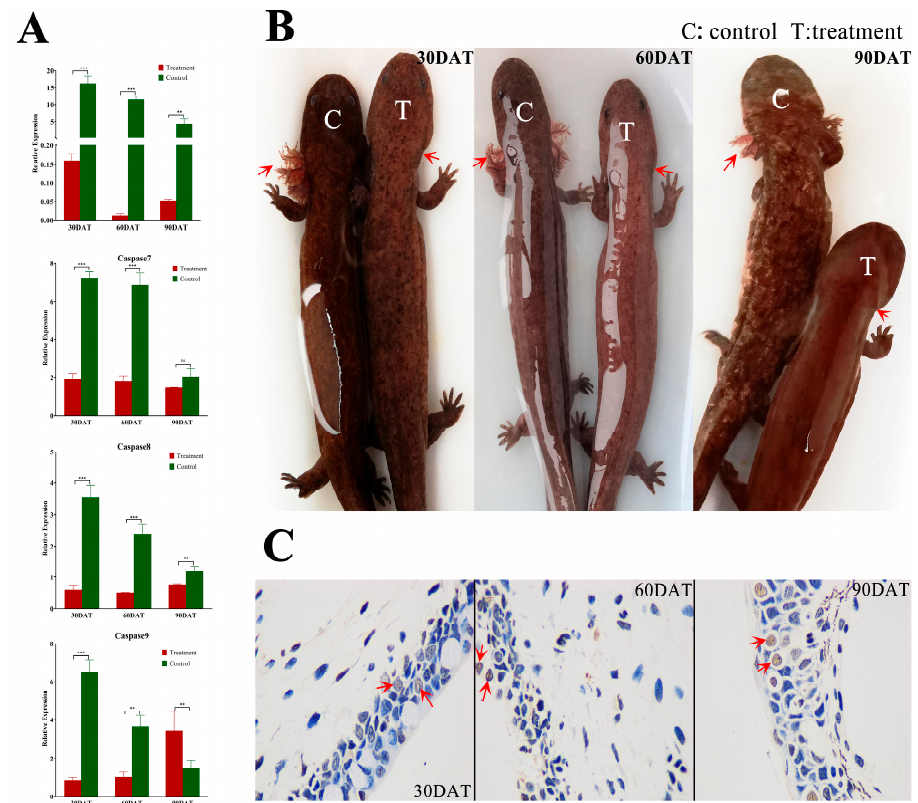
Figure 5. TH treatment results for 8-MOA Chinese giant salamanders at three sampling time points (30 DAT, 60 DAT and 90 DAT). ( A ) Relative expression levels of caspases 3/7/8/9 in the external gills of the Chinese giant salamanders after the TH treatment. Asterisks indicate significant differences from the control groups: **, p < 0.01; ***, p < 0.001; ns, no significance. ( B ) Comparison of external gill morphology between the TH-treated and control groups. ( C ) Apoptosis in the external gill of the Chinese giant salamander after the TH treatment, as seen using a TUNEL assay (400 × ). Red arrows indicate TUNEL-positive